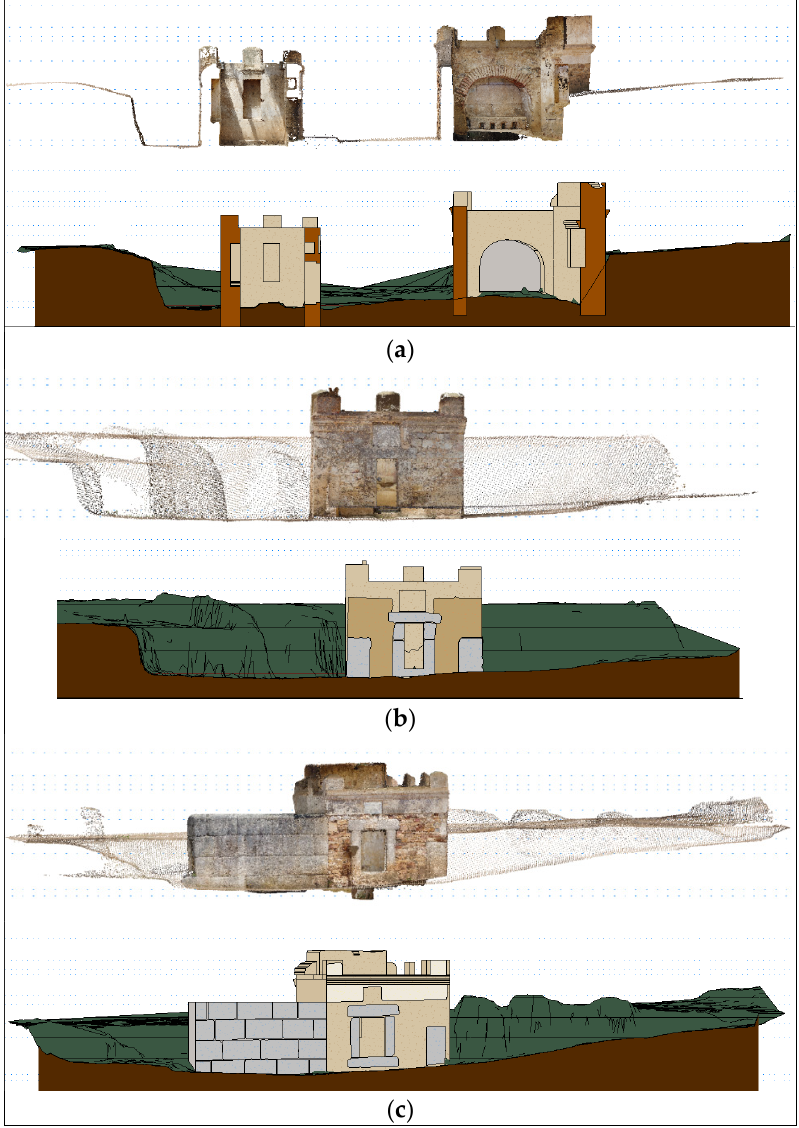
Figure 24. Comparative views of the survey obtained from the point clouds and the generated 3D model. We can see that the geometric accuracy of the point cloud is millimetric, while the 3D model is an approximation of the geometry of the buildings. ( a ) Longitudinal section of the point cloud (top) and of the model (bottom). ( b ) Elevation of the Voconios building. Point cloud above and model below. ( c ) Elevation of the Niger and Julios building. Point cloud above and model below.